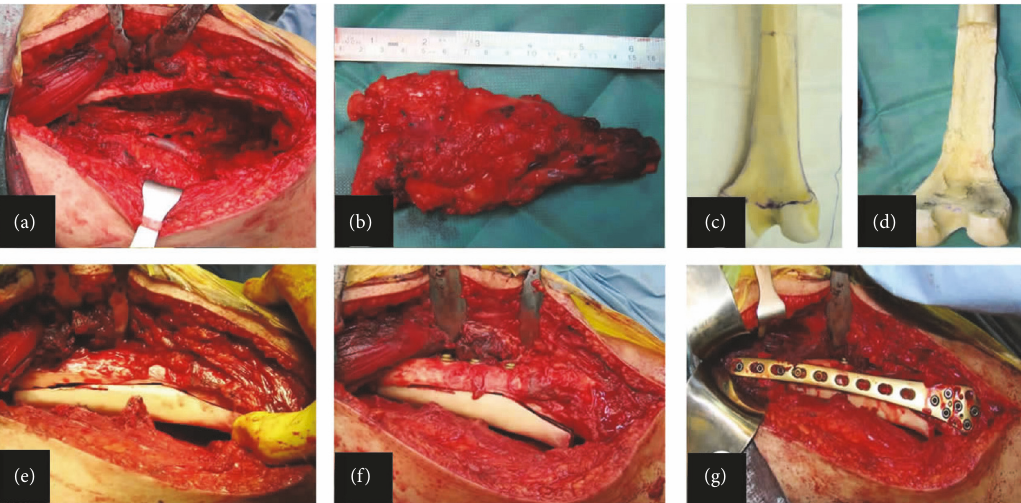
Figure 6: Intraoperative images showing (a) midline longitudinal incision at the posterior aspect of the distal femur and hemicortical resection. (b) Tumor resection. (c) Distal femur allograft. (d) Preparation of the allograft. (e) Matching the allograft to the bone deficit. (f) Allograft fixation with four cortical screws in the anteroposterior direction (g). The anatomical distal femoral plate is used as a bridging